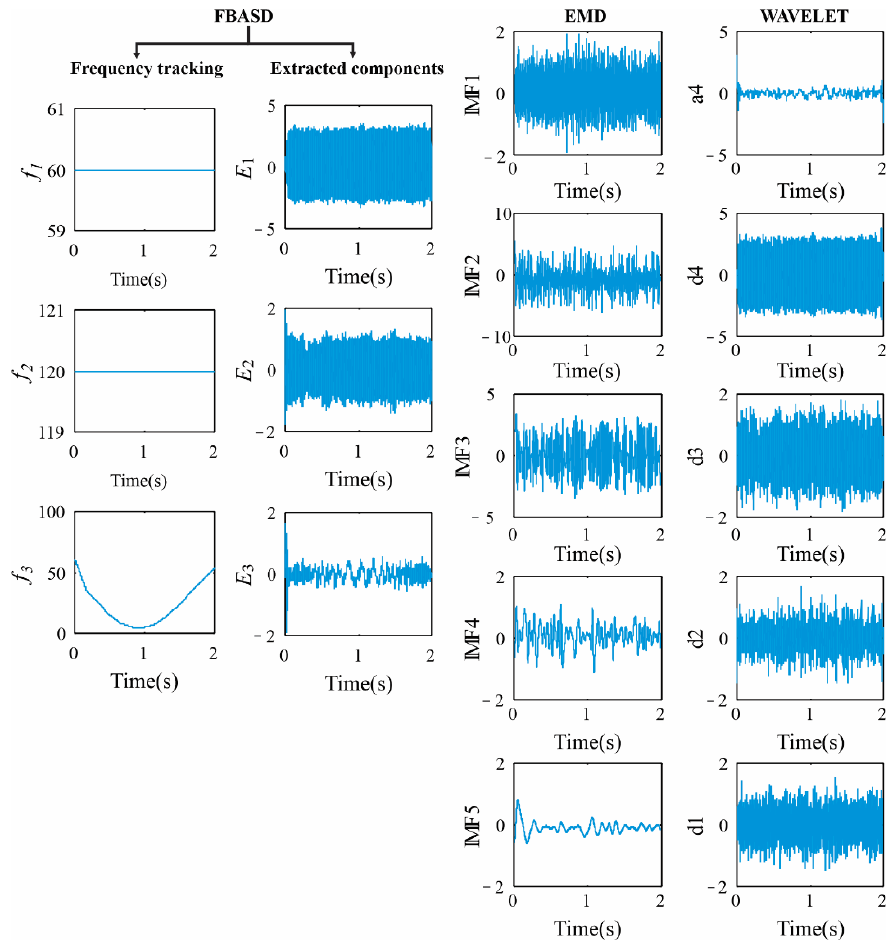
Figure 8. Simulation results with added noise.